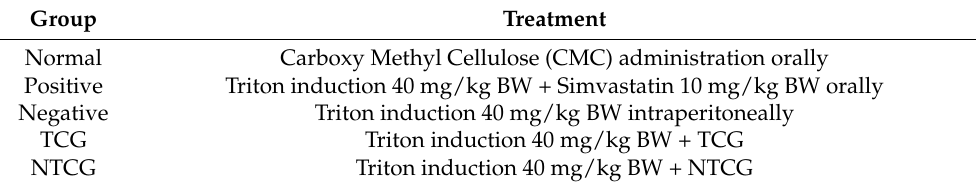
Table 9. Group of animal